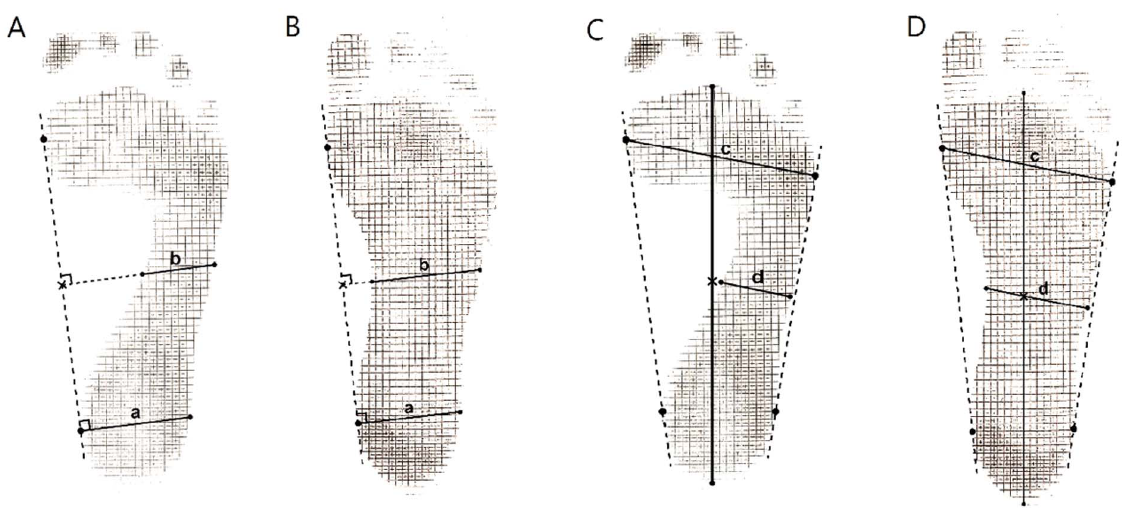
Fig. 1. Measure of SAI 5 b/a in non-flatfoot (A) and flatfoot (B); measure of CSI 5 d/c in non-flatfoot (C) and flatfoot